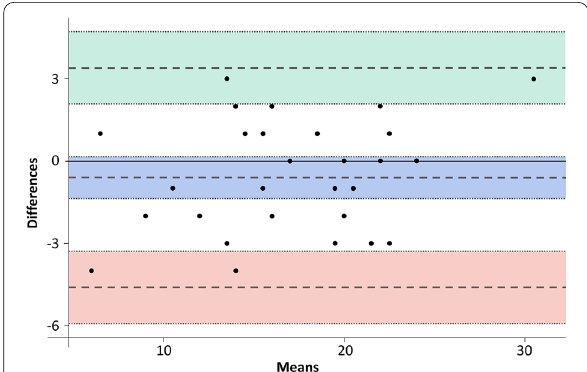
Fig. 3 Bland–Altman scatter plot comparing PAR T0 index measurements performed at two different times